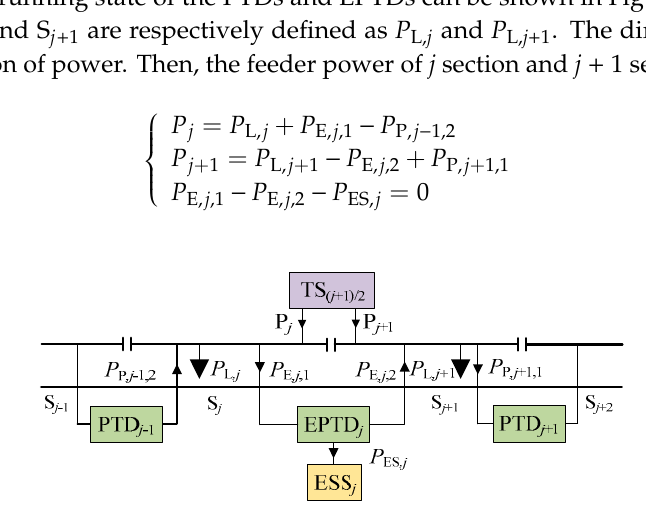
Figure 8. Power quality improvement by EPTD.